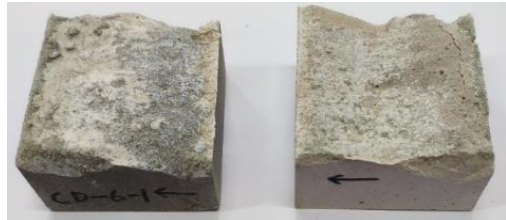
Figure 14. Failure surfaces of CD-3 after the first shearing.